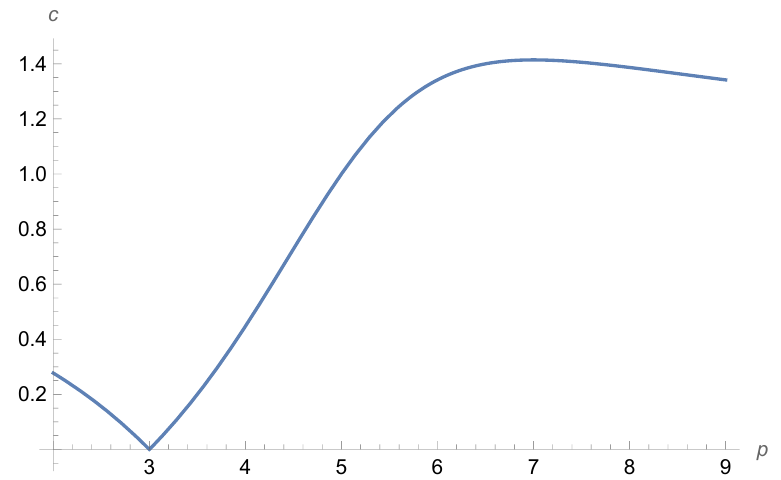
Figure 1 . Graph of c ( p, d = 6) as obtained in (4.39). The behaviour of this function is qualitatively the same for any dimension 2 < d < 10